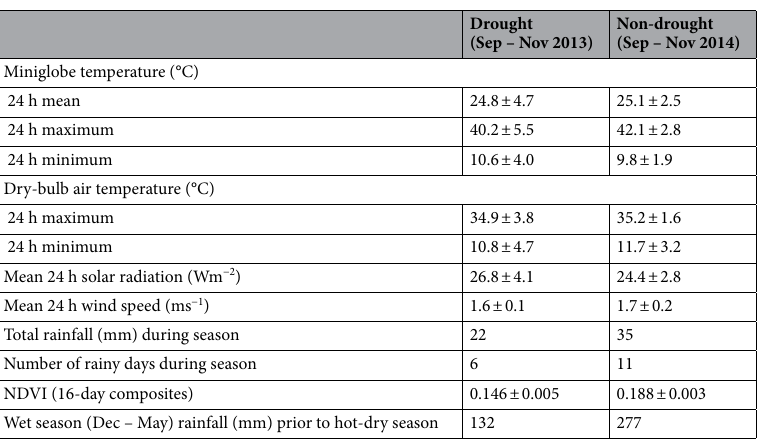
Table 1. Environmental conditions (mean ± SD) that prevailed in the two hot-dry seasons over the study period within the Bakgalagadi Schwelle,